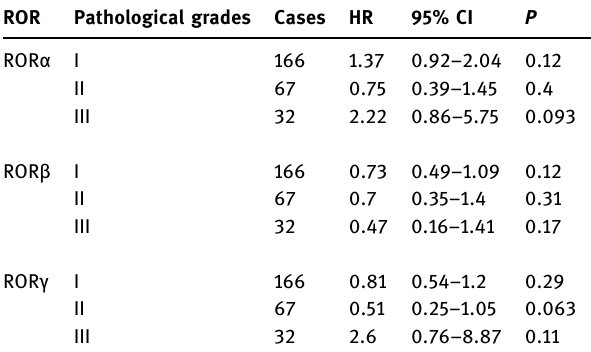
Table 1: Correlation of RORs mRNA expression with clinical stages of patients with GC ROR Clinical stages Cases HR